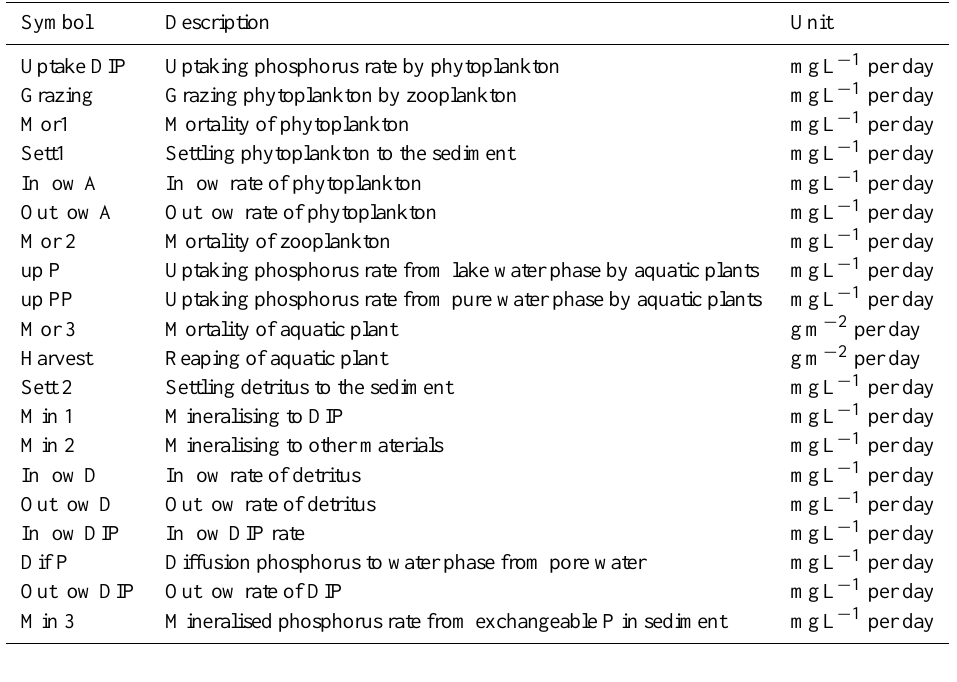
Table 2. Conversion process for each state variable.